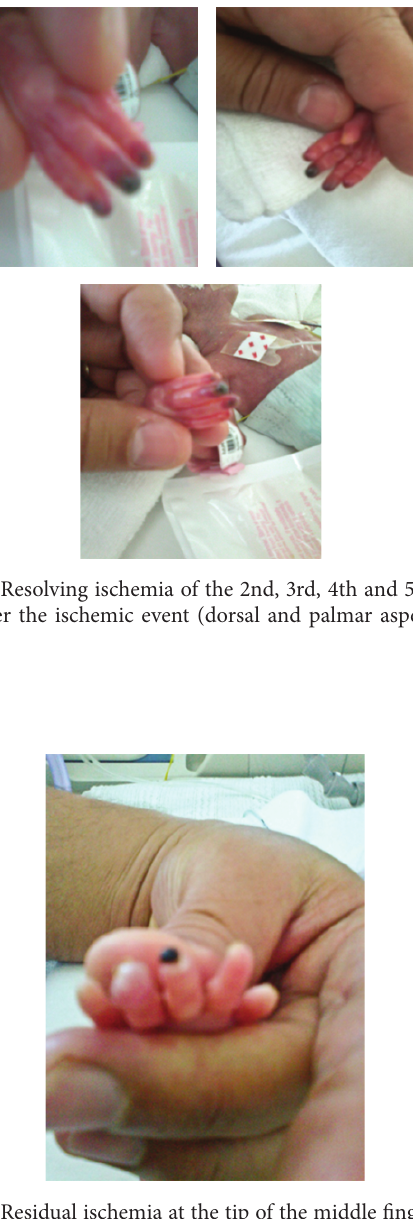
Figure 4: Residual ischemia at the tip of the middle finger after 10 days.